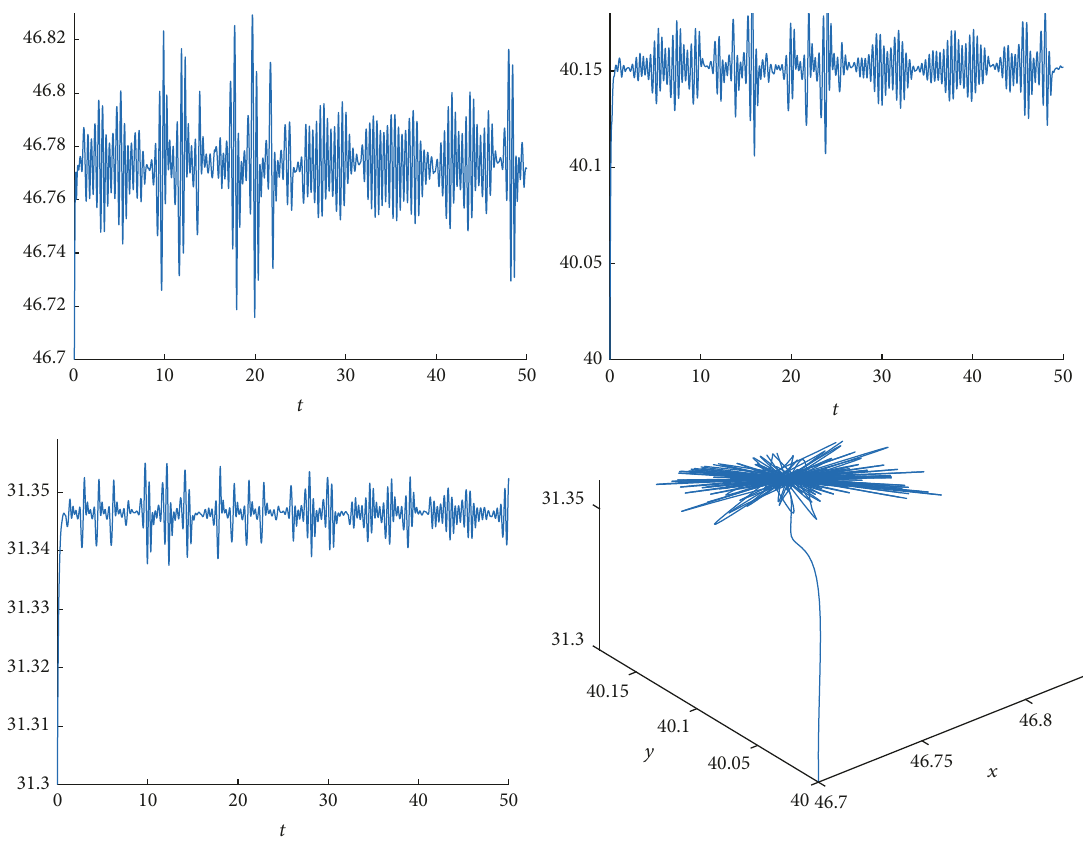
Figure 8: Dynamical behaviors and phase space trajectories of the three fish